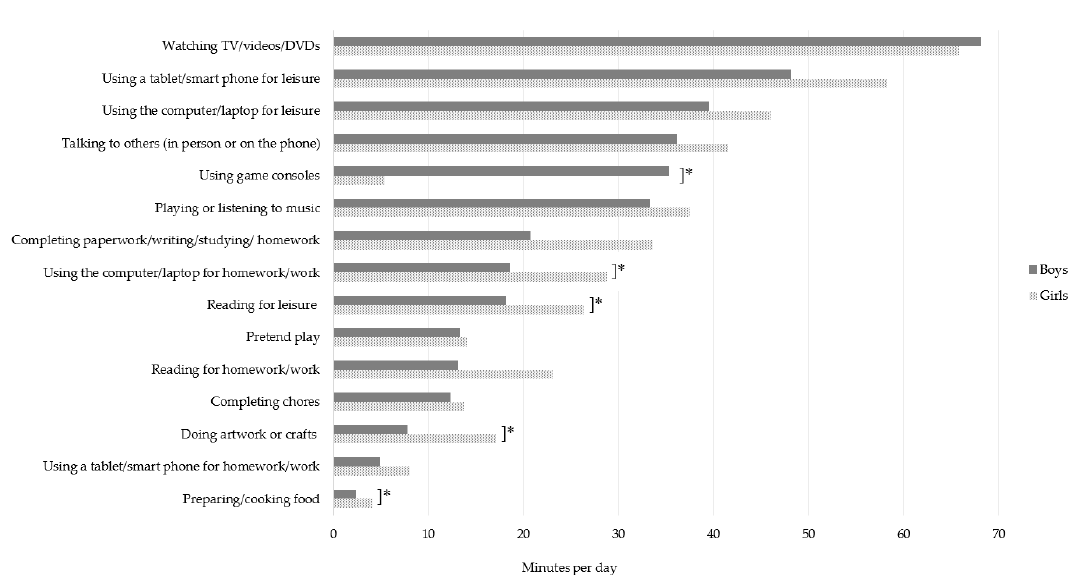
Figure 1. Total duration (minutes / day) of home-based sitting behaviours by sex. * Significant differences between boys and girls determined by independent samples t -tests, p < 0.05.